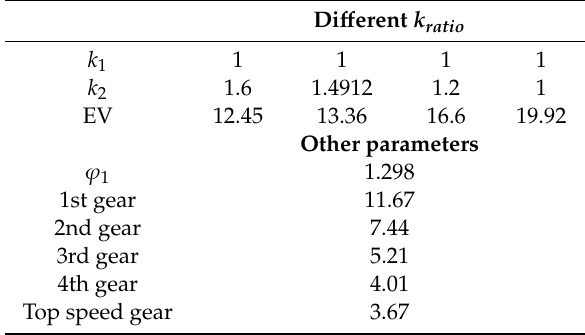
Table 3. Gear ratio design